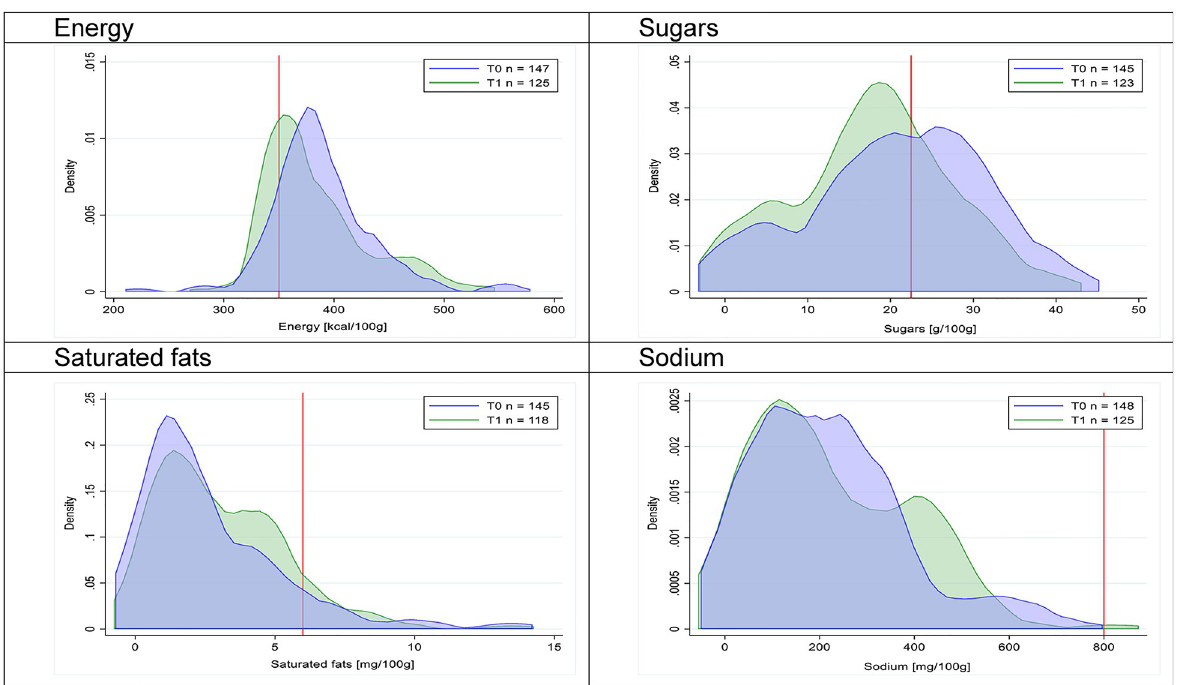
Fig 5. Density curves for the amount of energy and nutrients of concern in breakfast cereals, cross-sectional samples. The blue line represents the distribution in T0 (preimplementation), the green line represents the distribution in T1 (postimplementation), and the red line represents the cutoff for the amount of energy or nutrients of concern.